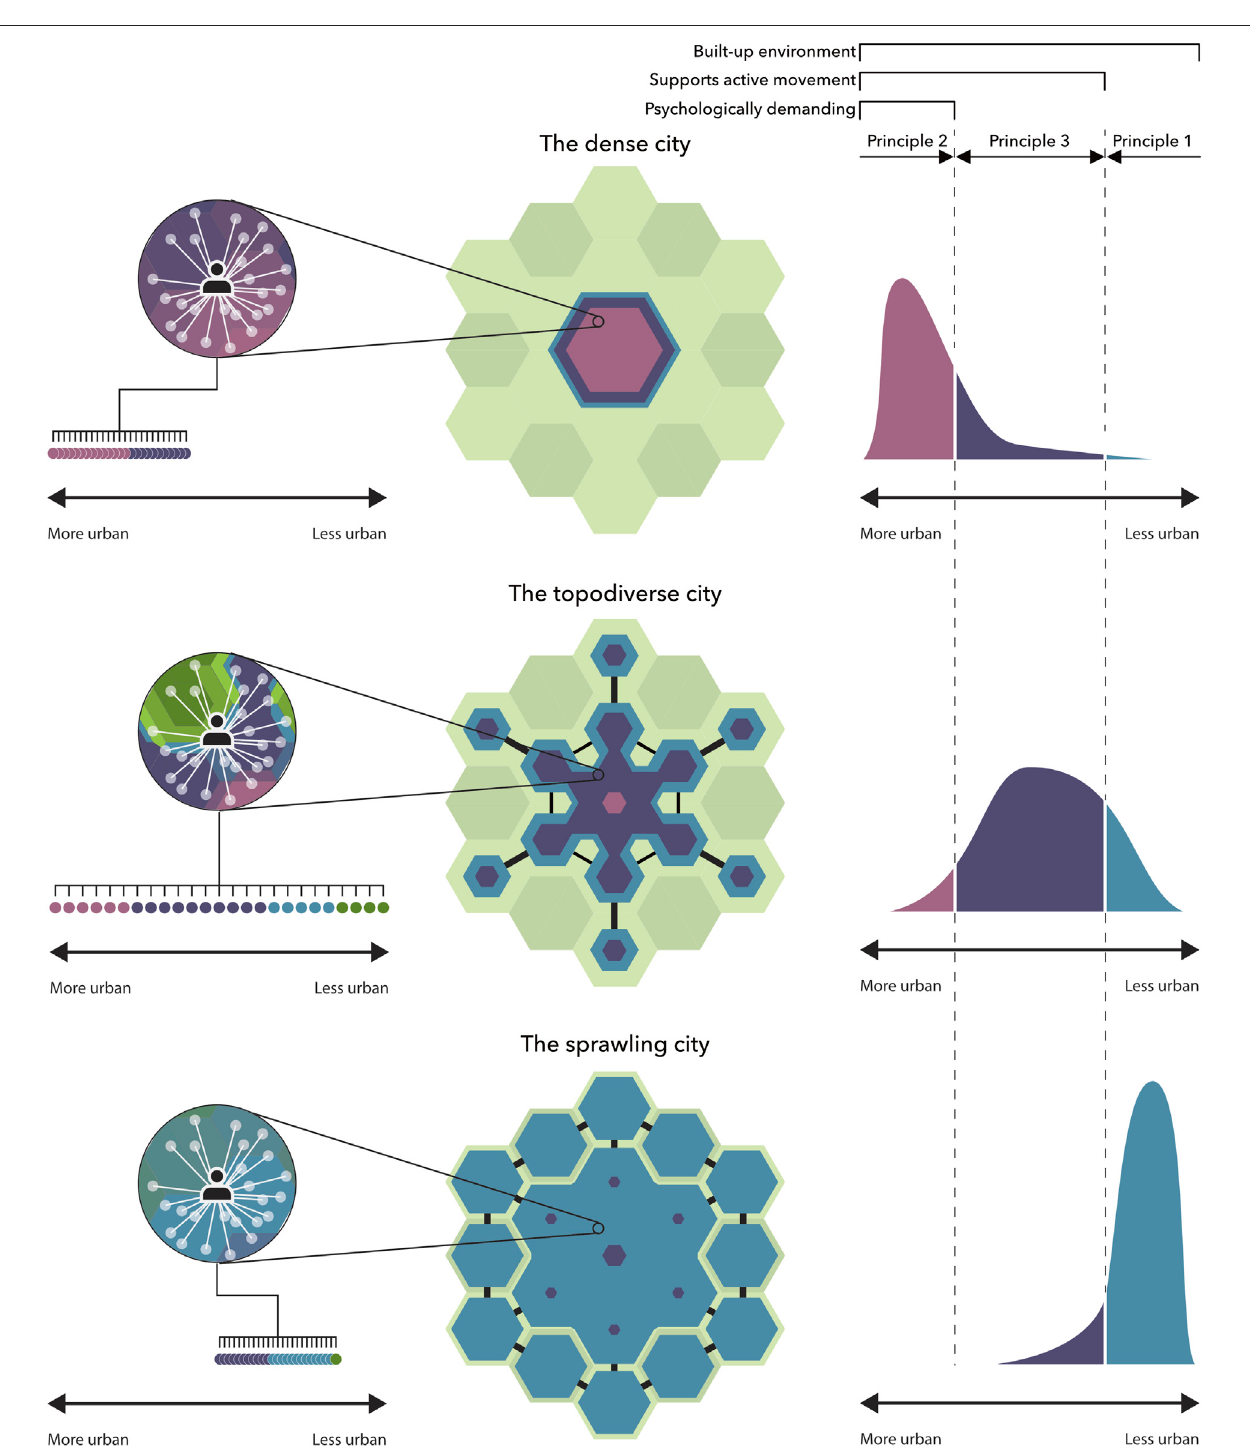
FIGURE 1 | A comparison of the topodiverse city with the dense city and sprawling city, respectively. The middle column shows three schematic illustrations of urban form, basedonthelayoutoftenusedtoillustratecentralplacetheory(Christaller,1933).Thetopodiversecityismorespatiallycontainedthanthesprawlingcity,butnotascompactasthe densecity,andhasamacroscalepolycentricstructurewithmanylocalmaximaofurbanity.Thespatialconditionsunderpinningtopodiversityareforillustrativepurposescollapsedtoa one-dimensional scale of urbanity. The column to the right shows schematic histograms of all built-up environments along this scale. The sprawling city, by not adhering to Principle 1, has most of its environments not supporting active movement (blue). The dense city, by not adhering to Principle 2, has most of its environments being psychologically demanding(red).Thetopodiversecityhasmostofitsenvironmentsinbetween(purple).Thecolumntotheleftzoomsinontheneighborhoodofanindividual,mappingthe25places ofhisorheractivityplacesetalongthescaleofurbanityforeachofthethreeurbanforms.ByadheringtoPrinciple3,thetopodiversecityallowsindividualstoconstructalocalactivity space supporting subjective well-being through several pathways.